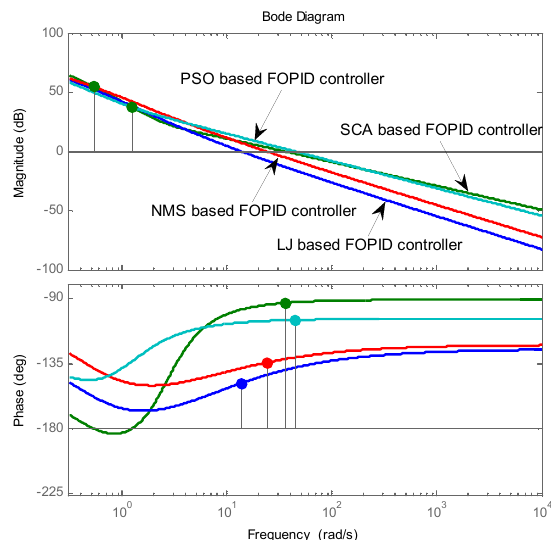
Figure 15. Bode response of controlled HOCIP with the FOPID controller.